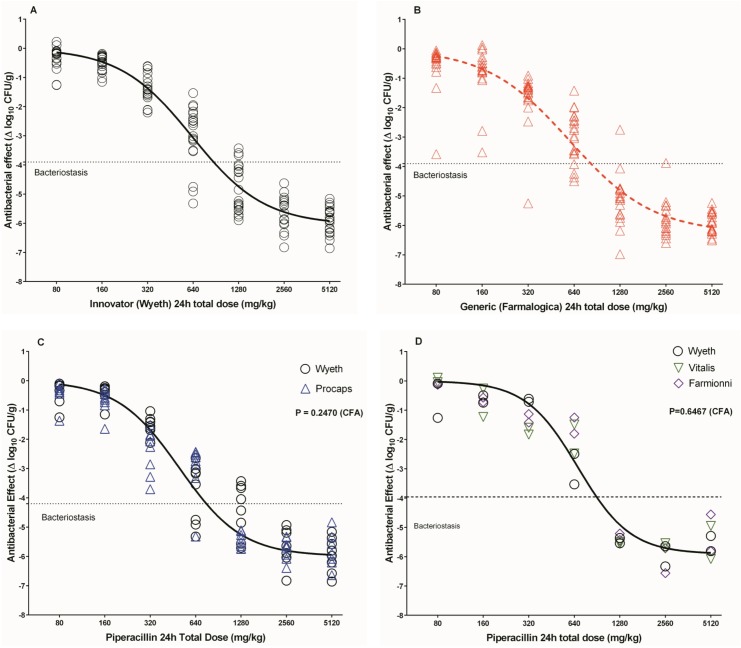
In vivo pharmacodynamics of innovator and generic TZP against E. coli ATCC 35218 in the NMTIM.A. Pharmacodynamics of innovator (Wyeth) TZP from 5 independent experiments. The graph shows the dose-response curve of the innovator (black open circles) with a valid regression. B. Pharmacodynamics of generic TZP (Farmalogica) from 5 independent experiments. The regression is invalid for failing the normality of the residuals assumption (the dotted curve implies a faulty fit). Compared with the innovator (panel A), the dose-response relationship of Farmalogica is erratic and the data more dispersed. C. Therapeutic equivalence of generic TZP (Procaps, blue open triangles) with the innovator (Wyeth, black open circles), combining data from 2 independent experiments. Both products yielded valid regressions and the CFA demonstrated that a single curve described better the two datasets, indicating that this generic TZP was therapeutically equivalent to the innovator. D. Therapeutic equivalence of two generics of TZP (Vitalis, green open triangles; and Farmionni, purple open triangles) with the innovator (Wyeth, black open circles). All three products generics yielded valid regressions and the CFA demonstrated that a single curve described better the three datasets, indicating that both generics were therapeutically equivalent to the innovator.